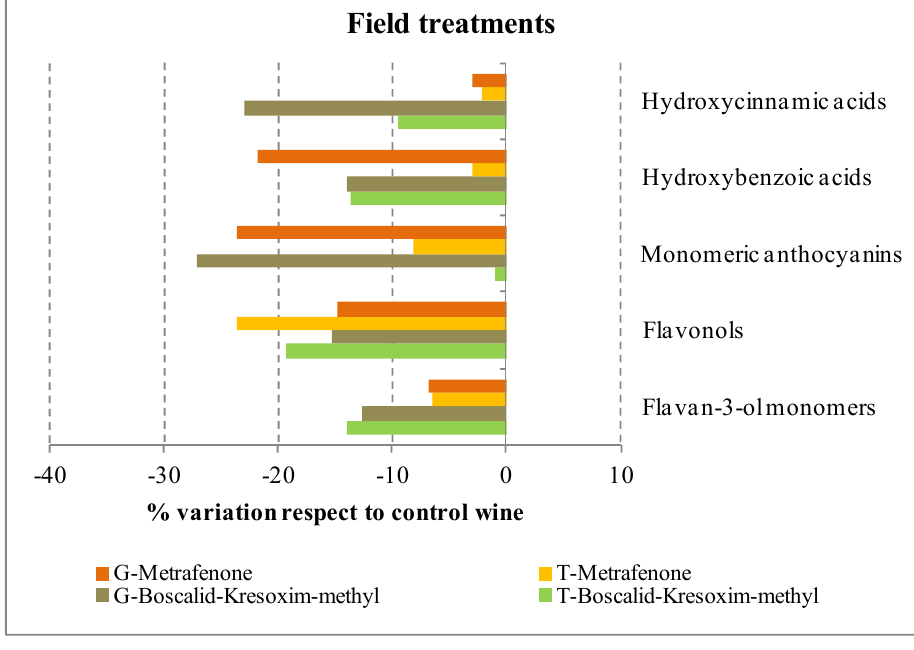
Figure 2. Effect of each antifungal treatment on the phenolic profile of Graciano (G) and Tempranillo (T)